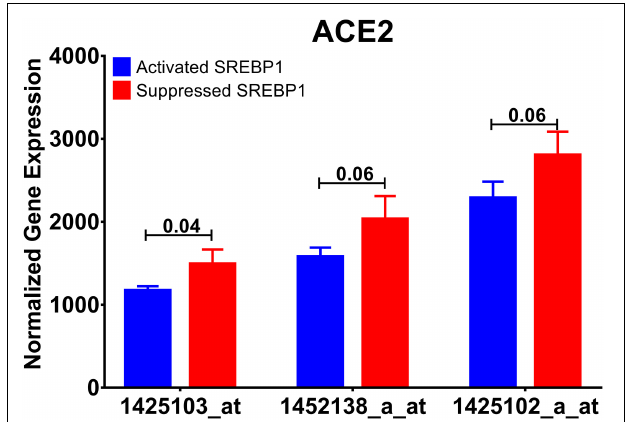
FIGURE 7 | Ace2 expression is regulated by SREBP. Normalized mRNA expression of Ace2 gene probes used in the publicly available dataset (GSE31797) comparing SREBP activated with SREBP inhibited alveolar cells.